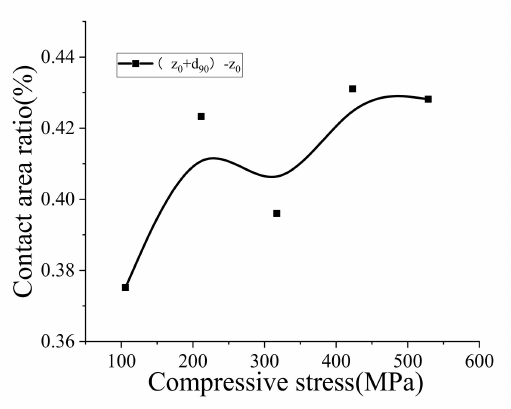
Figure 12. Relationship between the actual contact area ratio and compression stress.